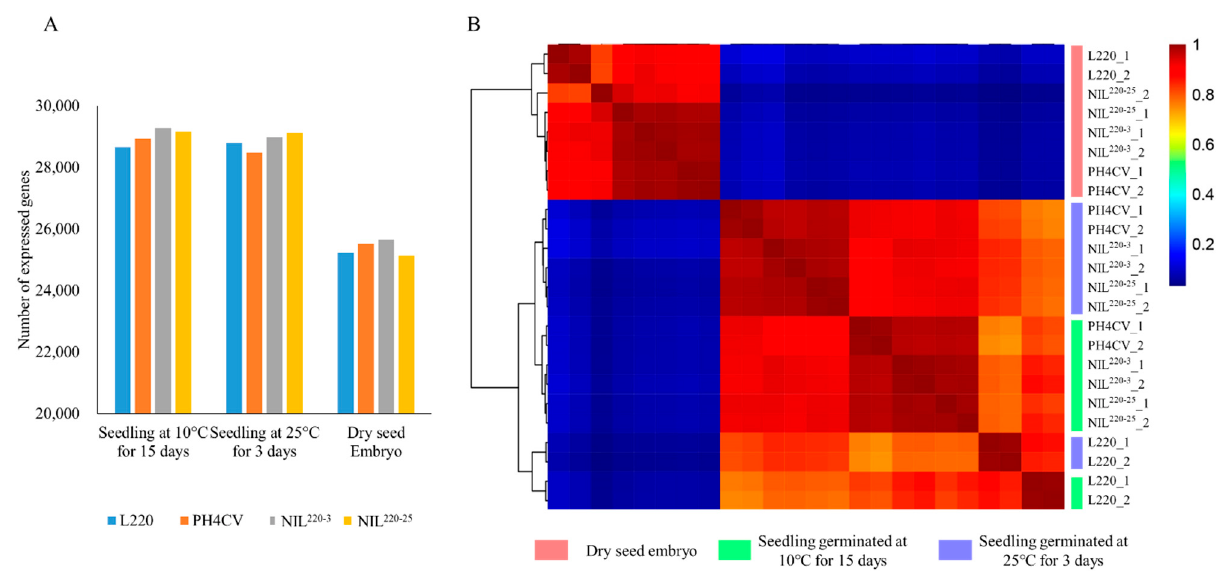
Figure 2. Identification of expressed genes from L220, PH4CV, and their near-isogenic lines NIL 220-3 and NIL 220-25 . ( A ) The number of expressed genes identified from different genotypes that germinated at 10 °C for 15 days and 25 °C for 3 days, and ungerminated dry embryo. Data were the average of two replications. ( B ) Heatmap clustering of the expressed genes. Pink, green, and blue columns presented vertically at the right side of the heatmap represent samples collected from dry embryo, seedlings germinated at 10 °C for 15 days, and seedlings germinated at 25 °C for 3 days, respectively. Red and blue represent high and low abundance, respectively, according to the normalized FPKM. The numbers 1 and 2 after the genotype represent replicates 1 and 2, respectively. Table 1. Summary of transcriptome sequencing.